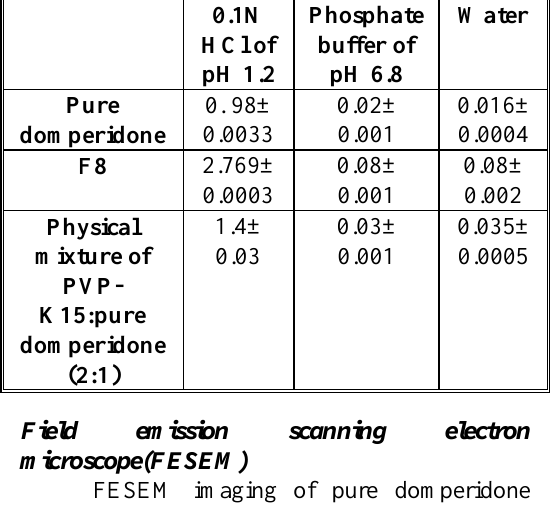
Table 2. Average of particle size ranges (n=3), averages, poly dispersity index (PDI) and specific surface area (SSA) of prepared domperidone nanoparticles.